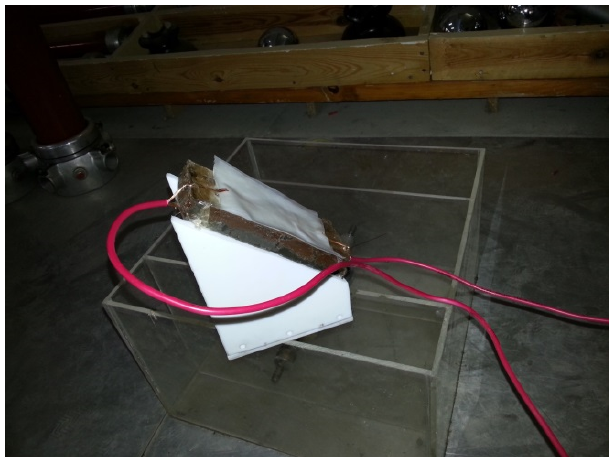
Figure 3. Experimental setup